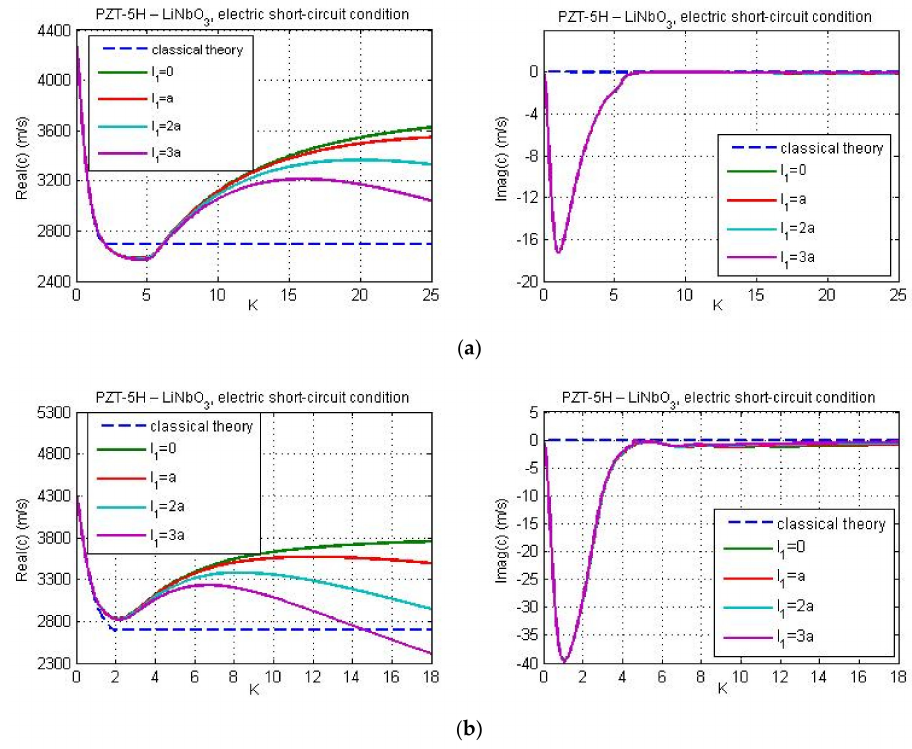
Figure 5. The real and imaginary parts of phase velocity c versus non-dimensional wave number K for different values of micro-inertia length in case of electric short-circuit conditions; guiding layer thicknesses: ( a ) 60 nm and ( b ) 25 nm.